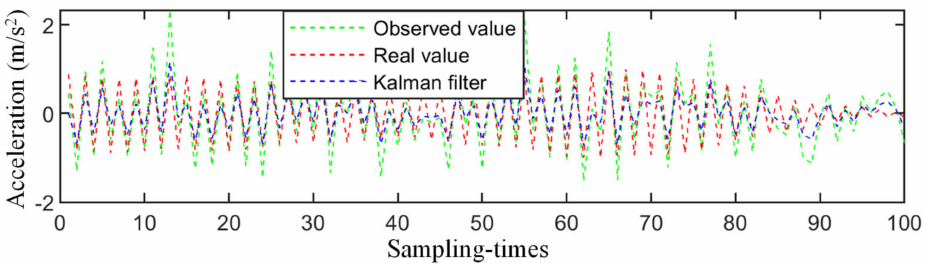
Figure 16. The denoise results of the Kalman filter.